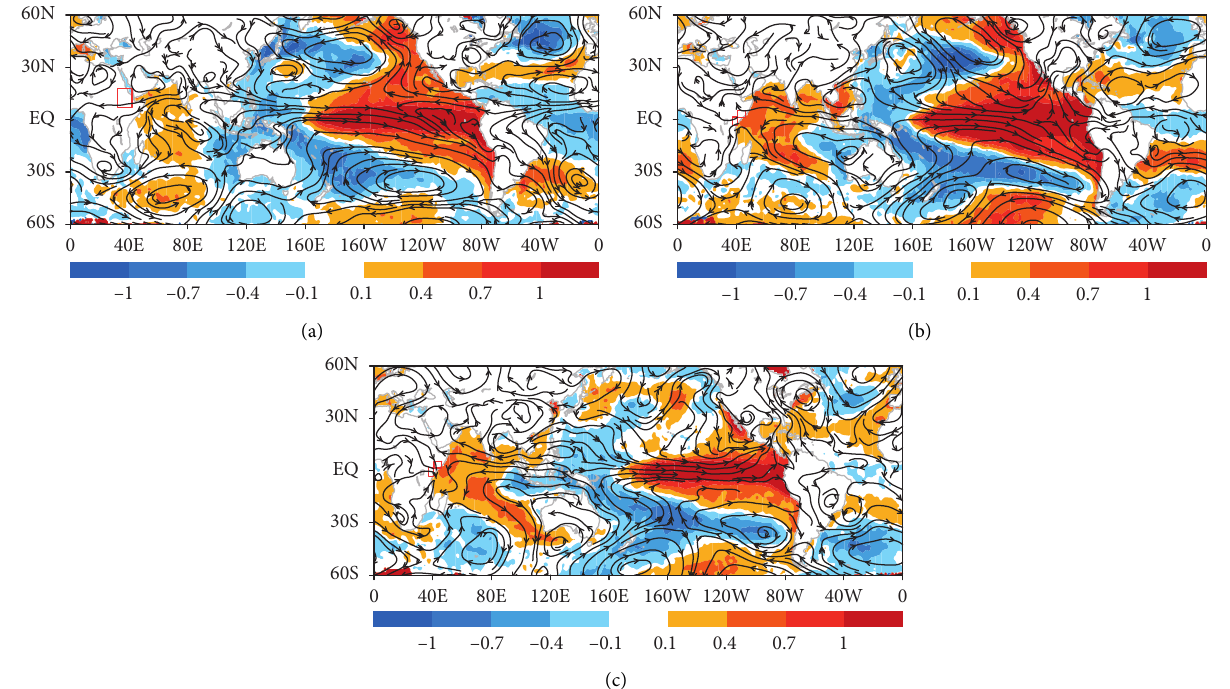
Figure 10: The difference of SST (shaded in ° C) and 850-hPa wind (streamline) in (a) JJAS between El Nin ̃ o years and La Nin ̃ a years, (b) OND between El Nin ̃ o years and La Nin ̃ a years, and (c) OND between pIOD years and nIOD